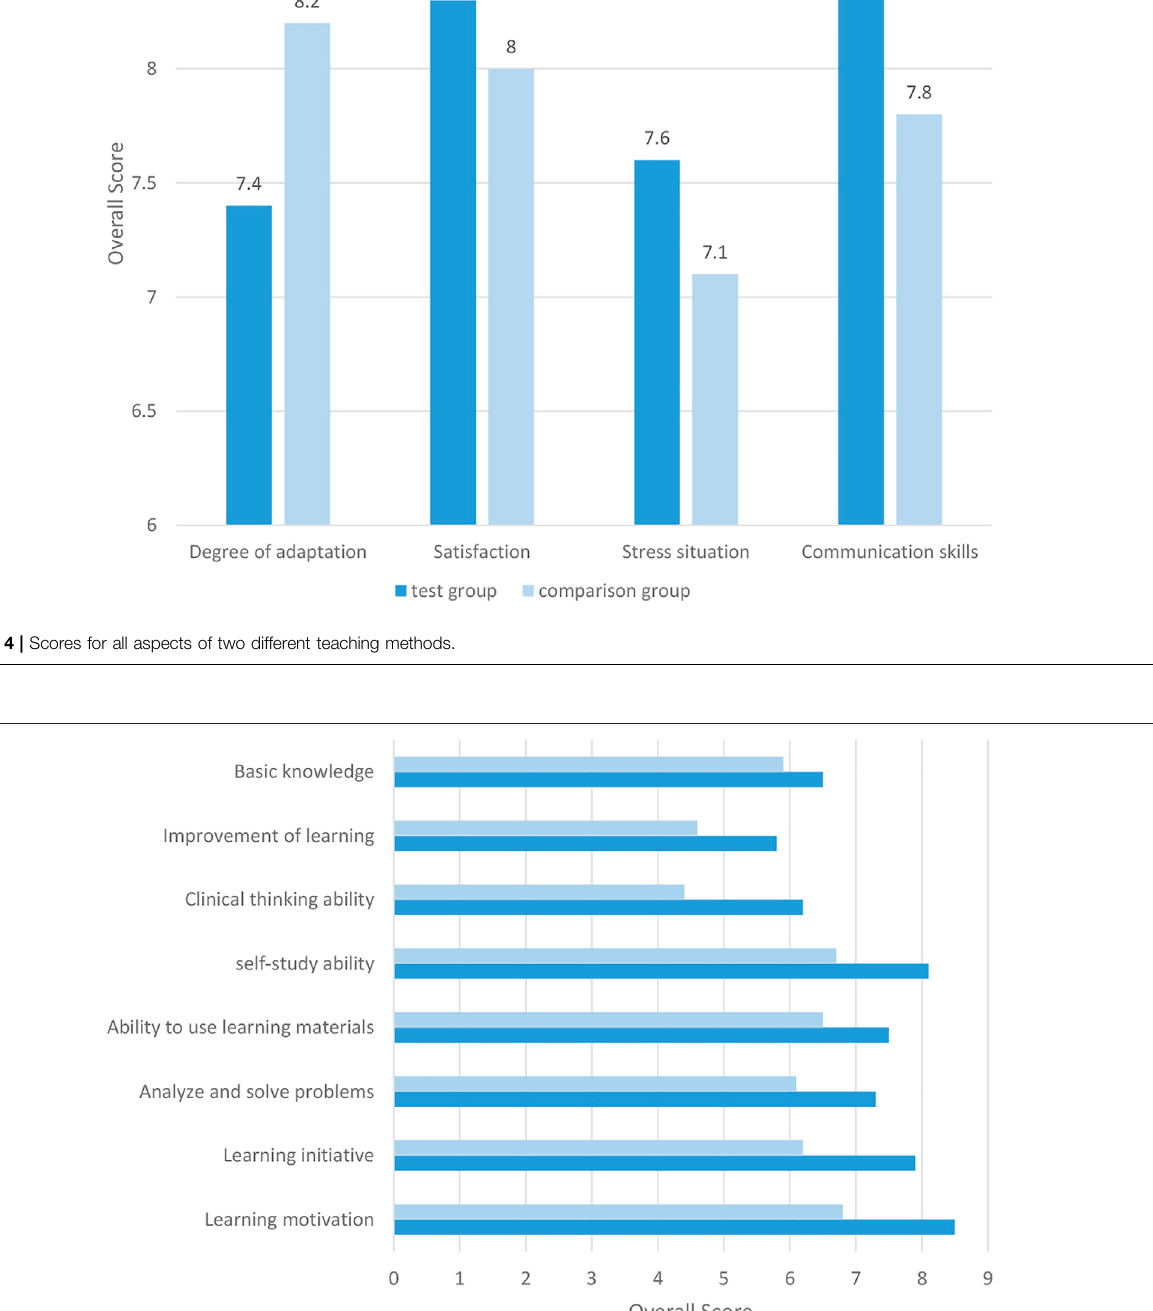
Frontiers in Genetics |